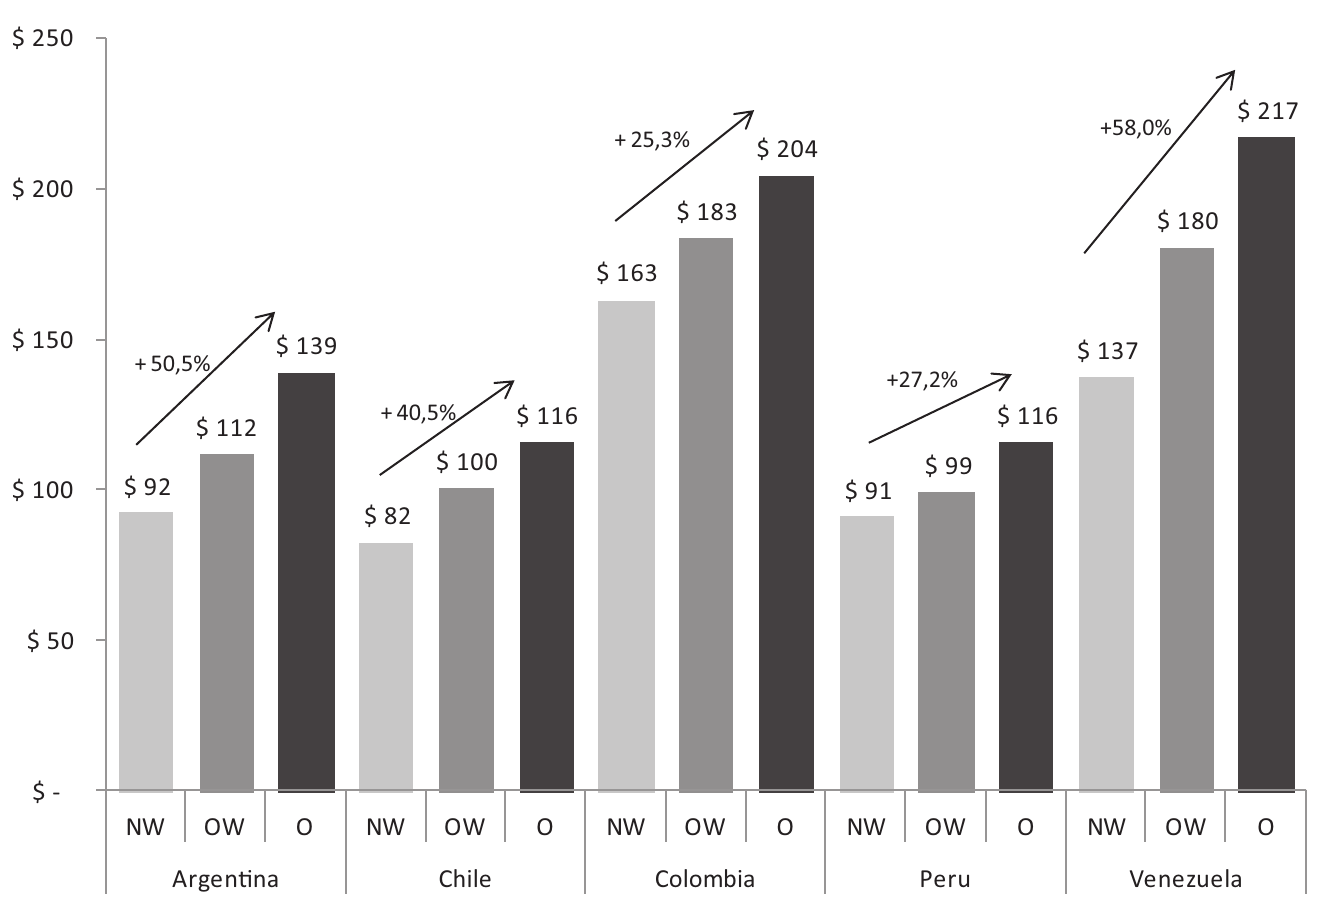
Fig 1. Total cost of drug treatment by country. NW: Normal weight (18.5 (cid:20) BMI < 25); OW: Overweight (25 (cid:20) BMI < 30); O: Obesity (BMI (cid:21) 30).